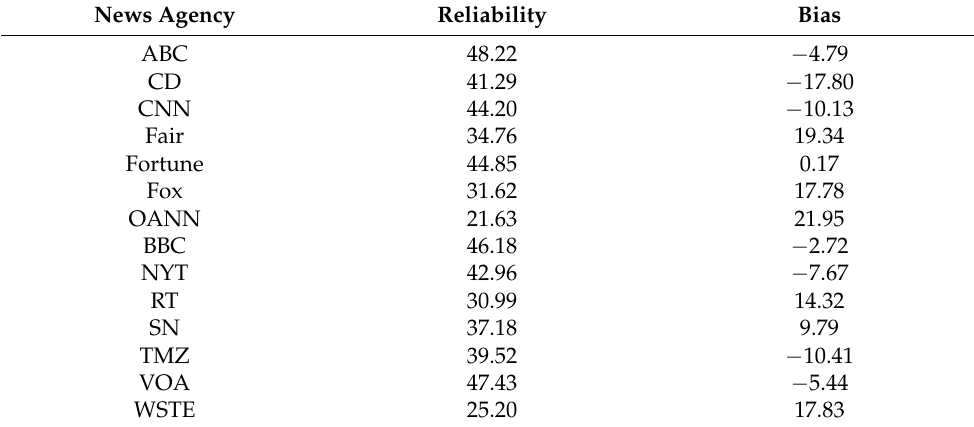
Table 3. The reliability and political bias of news